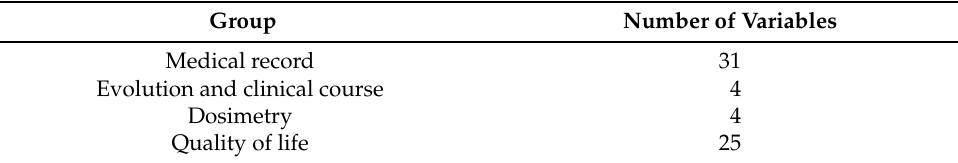
Table 3. The 64 variables chosen by the medical team, classified in their principal categories.